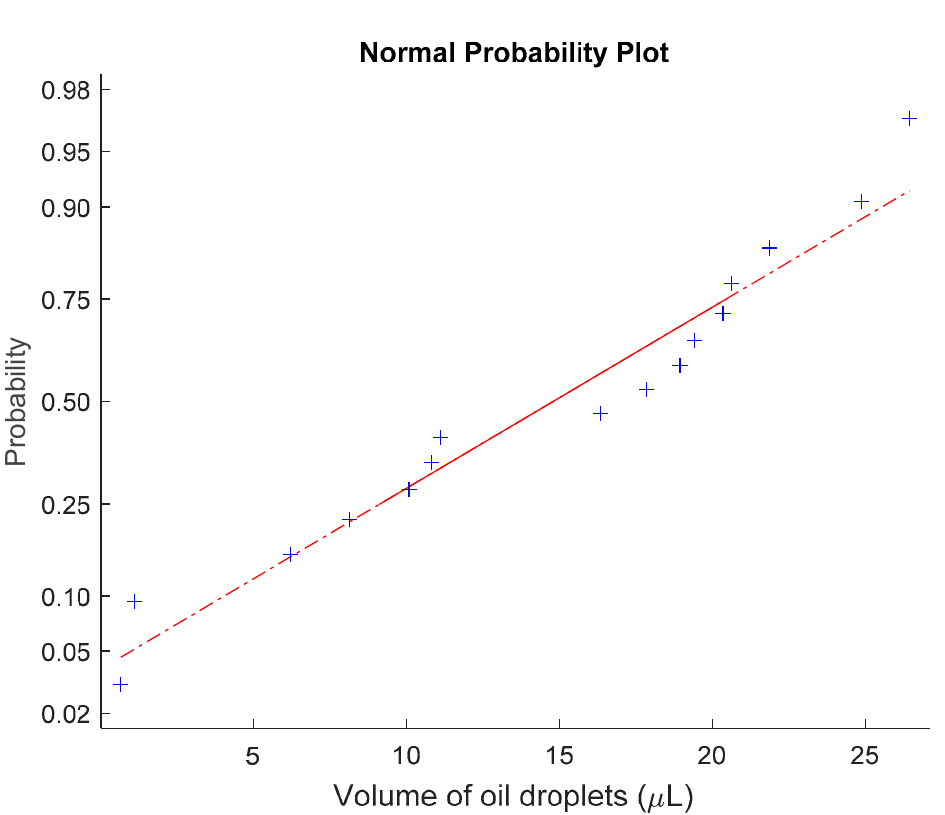
Figure A2. Normality probability check for the droplet size distribution from the experiment. The red line shows a realistic normal distribution, and the blue crosses indicate the experimental data.